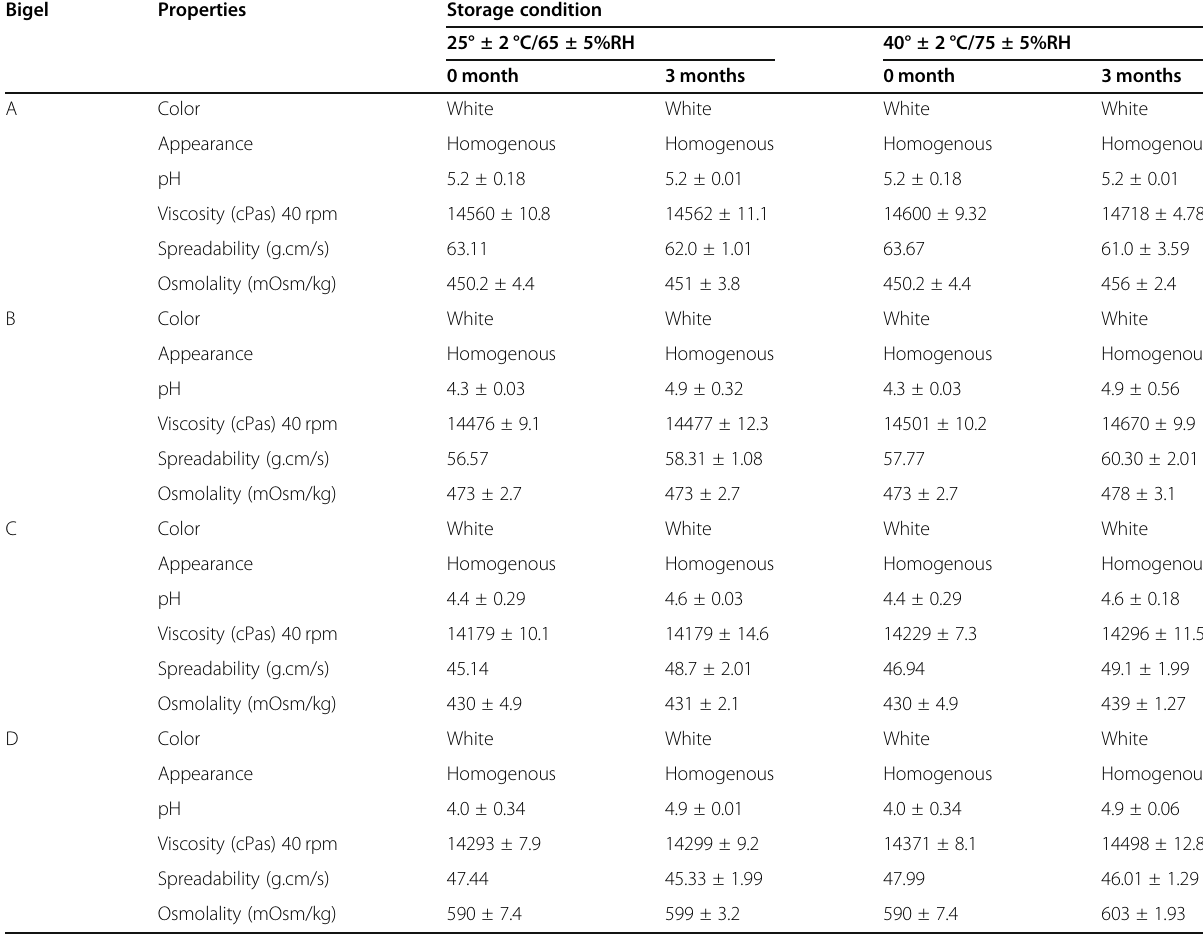
Table 2 Physicochemical testing of tenofovir and maraviroc bigel formulations